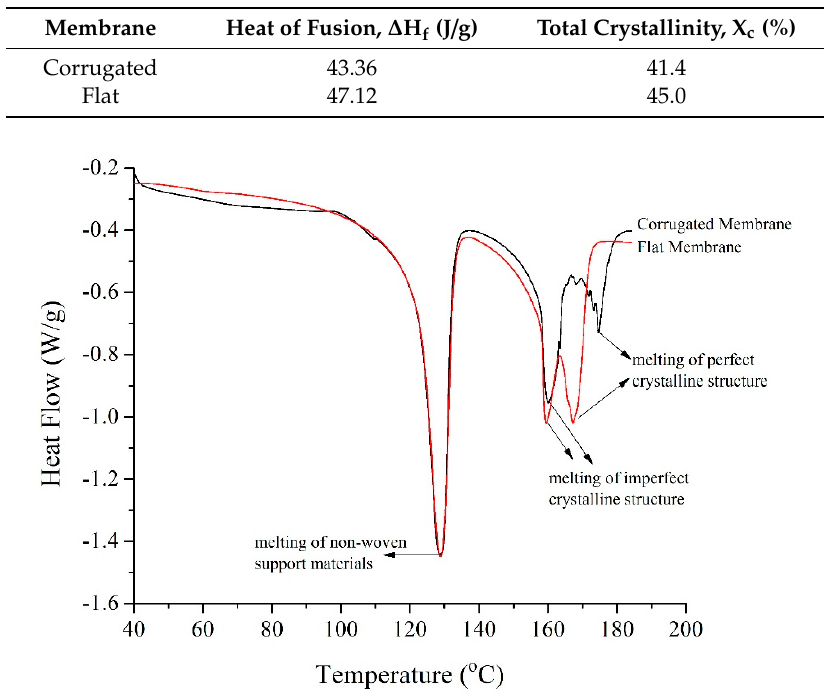
Table 3. Degree of crystallinity of the developed membranes based on Differential scanning calorimeter testing.